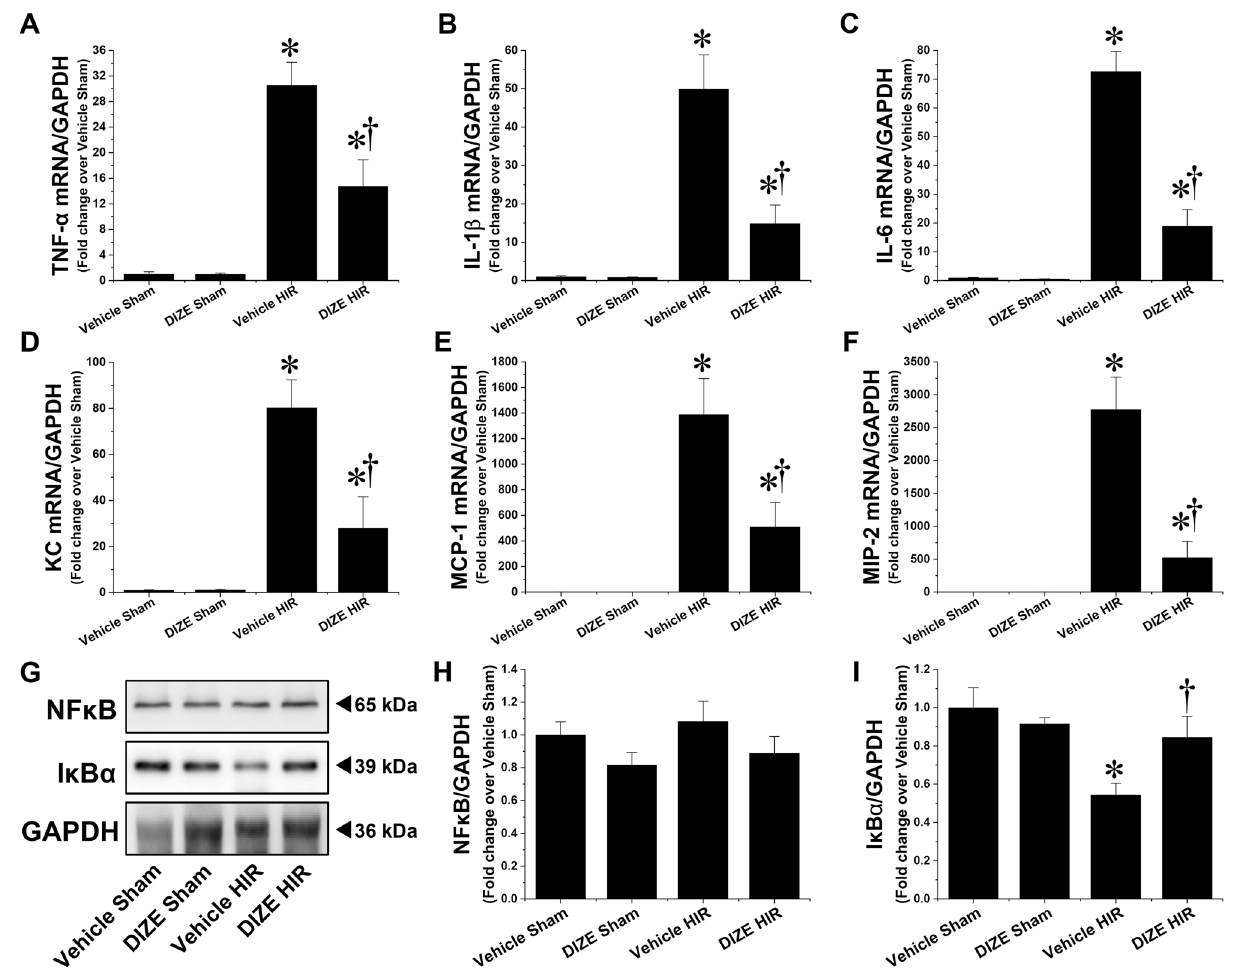
Figure 4. Effect of DIZE on hepatic inflammation following hepatic ischemia/reperfusion. C57BL/6 male mice were subjected to partial hepatic ischemia (HIR) induction for 1 h or sham surgery. Mice were treated with either Diminazene aceturate (DIZE) or vehicle control (saline) before undergoing surgery, as described in “Methods”. Fold-increases in the liver expression of pro-inflammatory mRNAs [tumor necrosis factor α ( TNF-α , A ), interleukin 1β ( IL-1β , B ), interleukin 6 ( IL-6 , C ), keratinocyte chemoattractant ( KC , D ), monocyte chemoattractant protein-1 ( MCP-1 , E ) and macrophage inflammatory protein-2 ( MIP-2 , F )] were assessed using quantitative RT-PCR 24 h after sham surgery or HIR induction; expression of GAPDH was used as reference control. ( G ) Liver samples were subjected to western blot analysis using anti-NFκB and -IκBα antibodies. ( H, I ) Band intensities were measured using the ImageJ v.1.53e software. Results are expressed as mean ± SEM (n = 5). For statistical analysis, one-way ANOVA with plus Tukey’s post hoc multiple comparison test were used to detect significant changes with Origin 2021 v.9.8.0 200 (OriginLab, https:// www. origi nlab. com) software. *P < 0.05 vs. Vehicle Sham. †P < 0.05 vs. Vehicle